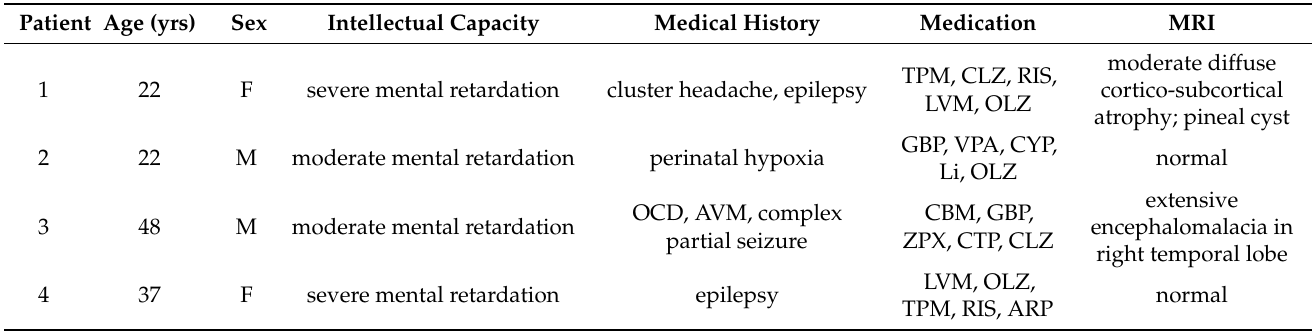
Table A2. Demographic and clinical findings.